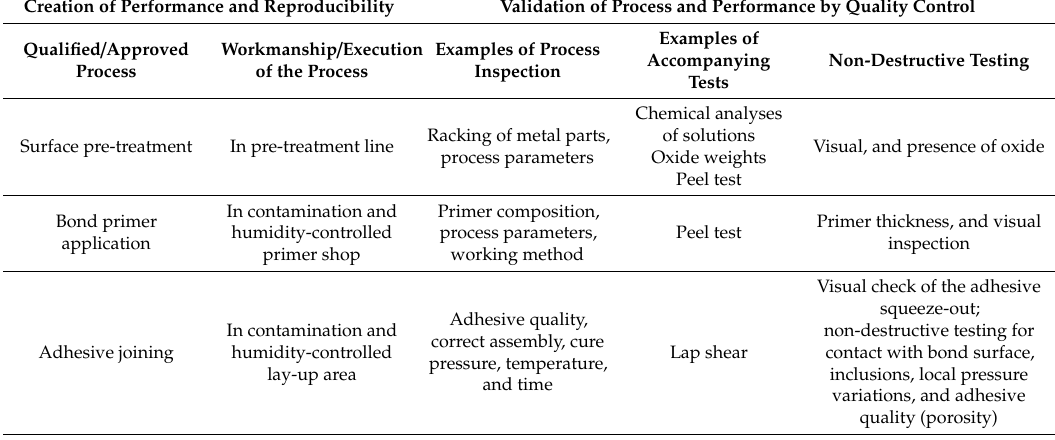
Table 4. Overview of activities of close control of the various steps of the fabrication process for structural metal